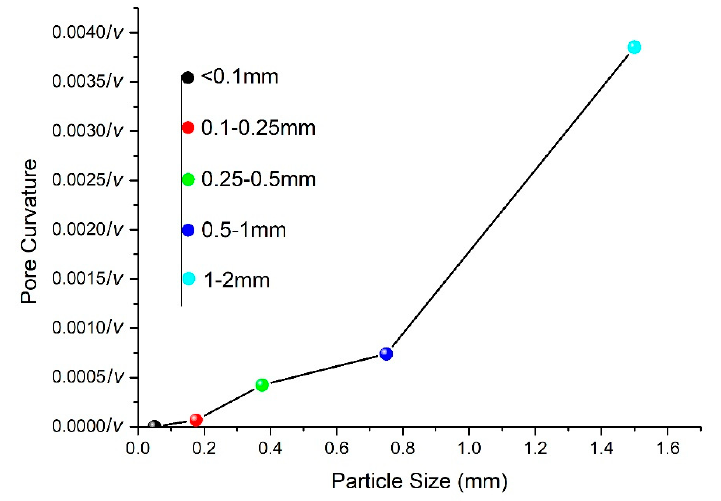
Figure 15. Relationship curve between pore tortuosity and particle size of coral sands.